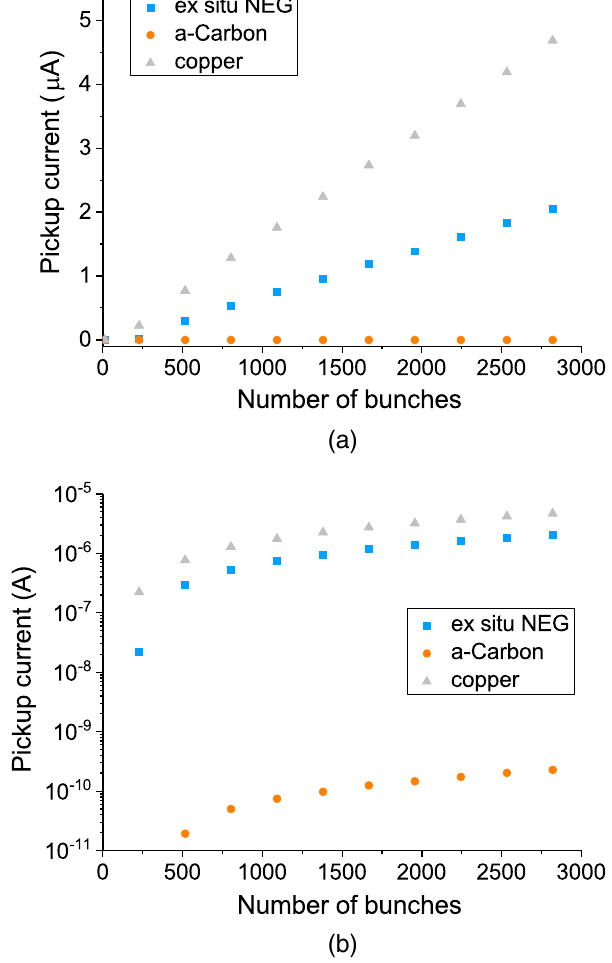
FIG. 5. Electrical signals (A) as a function of the number of bunches during the injection phase at 450 GeVof a 25-ns standard LHC beam in linear (a) and logarithmic (b)